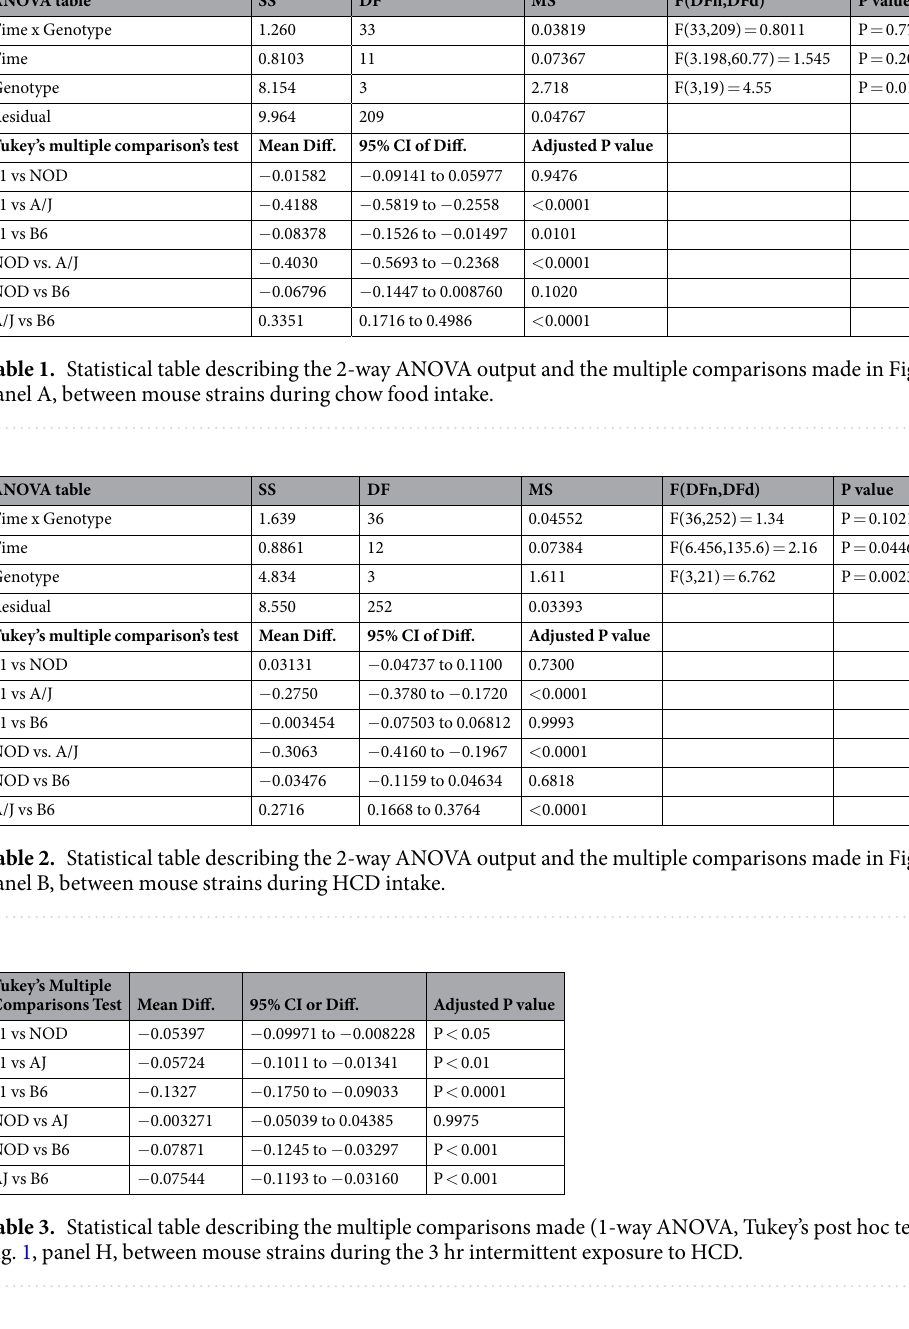
Counting of Fos + cells.